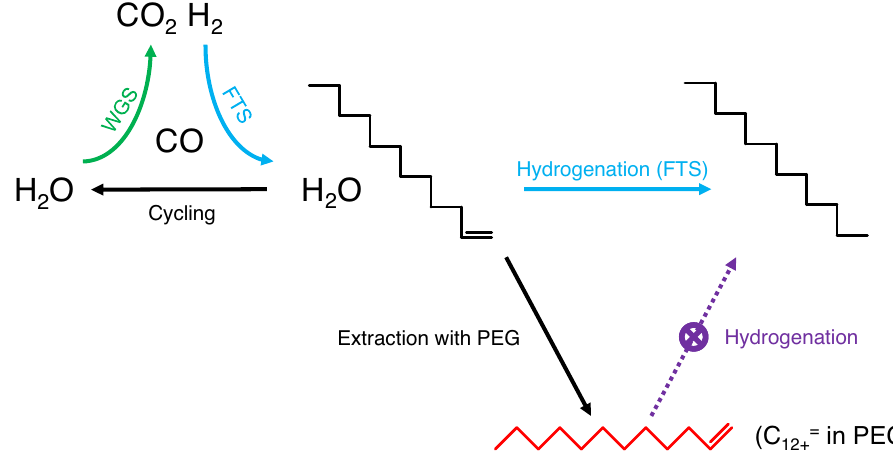
Fig. 2 | Scheme of sustained release of hydrogen via KES and selective extrac- tion to promote the production of extra-heavy ole fi ns. The green arrow repre- sents WGS. The azure arrows represent FTS, containing chain propagation and hydrogenation. The dark violet arrow represents hydrogenation of dissolved ole- fi ns. For KES, hydrogen accumulates through WGS and is gradually consumed